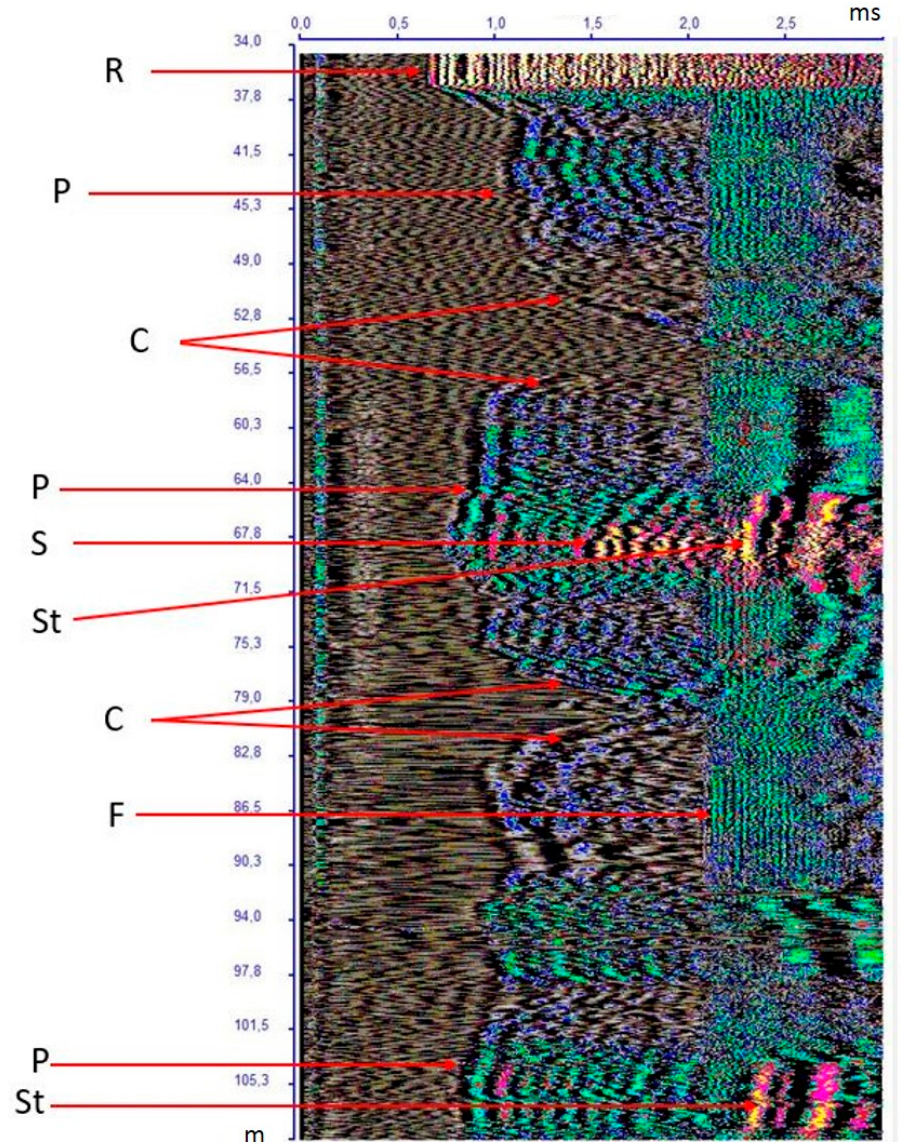
Figure 14. Acoustic section recorded in borehole MP7 (vertical axis: depth in m, horizontal axis: time in ms). P: refracted P-waves, S: converted refracted S-waves, St: Stoneley waves, F: fluid wave, C: criss-cross events, R: resonances due to the presence of a poorly cemented